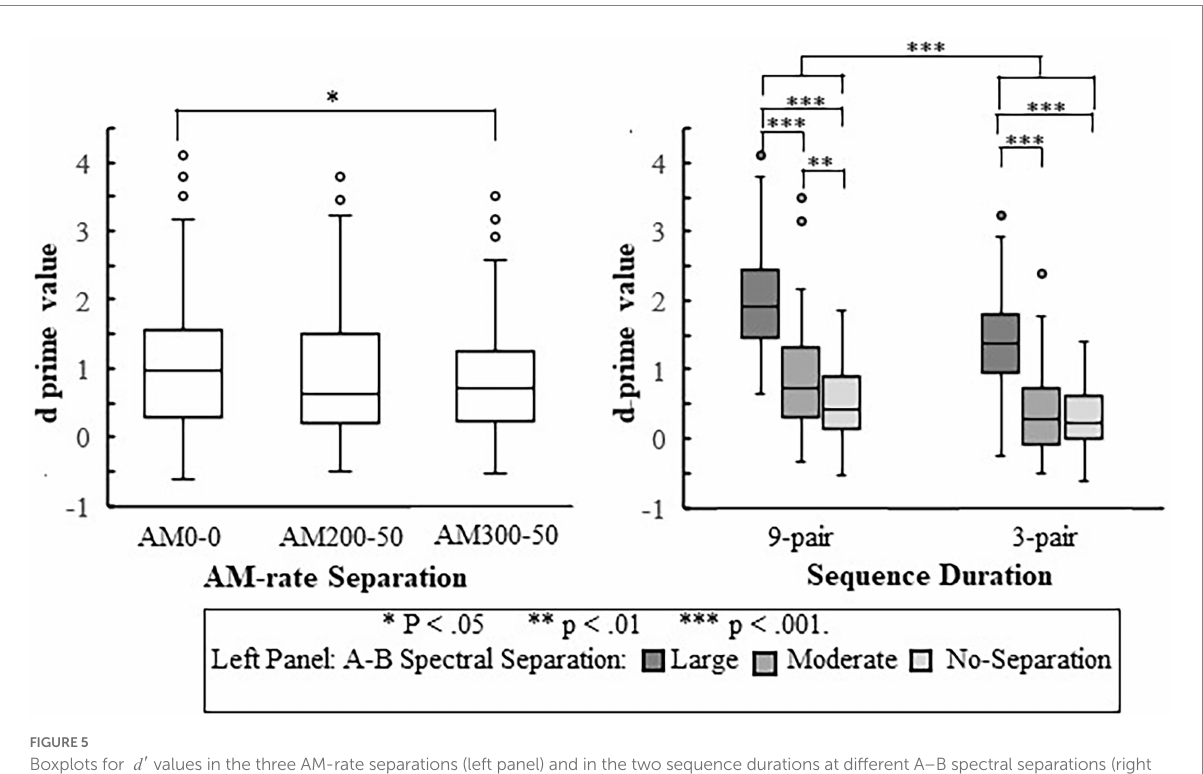
FIGURE 5 Boxplots for d ¢ values in the three AM-rate separations (left panel) and in the two sequence durations at different A–B spectral separations (right panel). The boxes show the 25–75th percentile, the error bars show the 5 and 95th percentile, the circle symbols show outliers, the solid horizontal line shows median performance. The statistically significant differences reported in the Results are indicated by